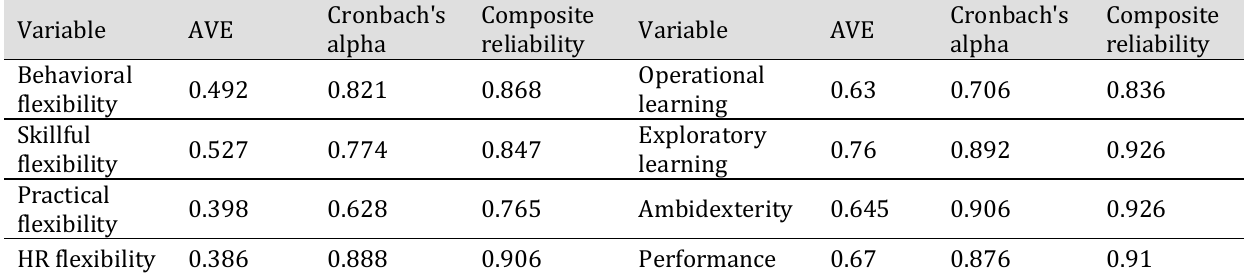
Table 2. Average variance extracted (AVE) values and reliability